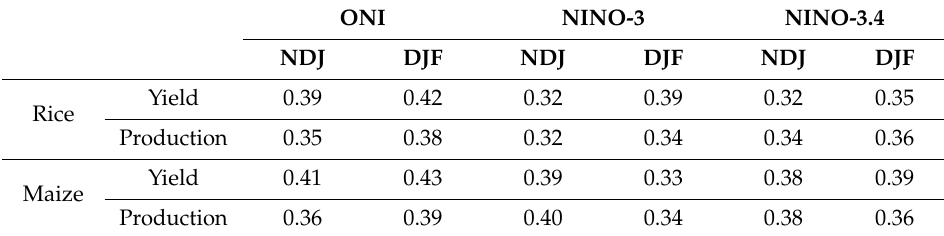
Table 5. Correlation of ONI, NINO-3, and NINO-3.4 with 5-year running mean of rice and maize.